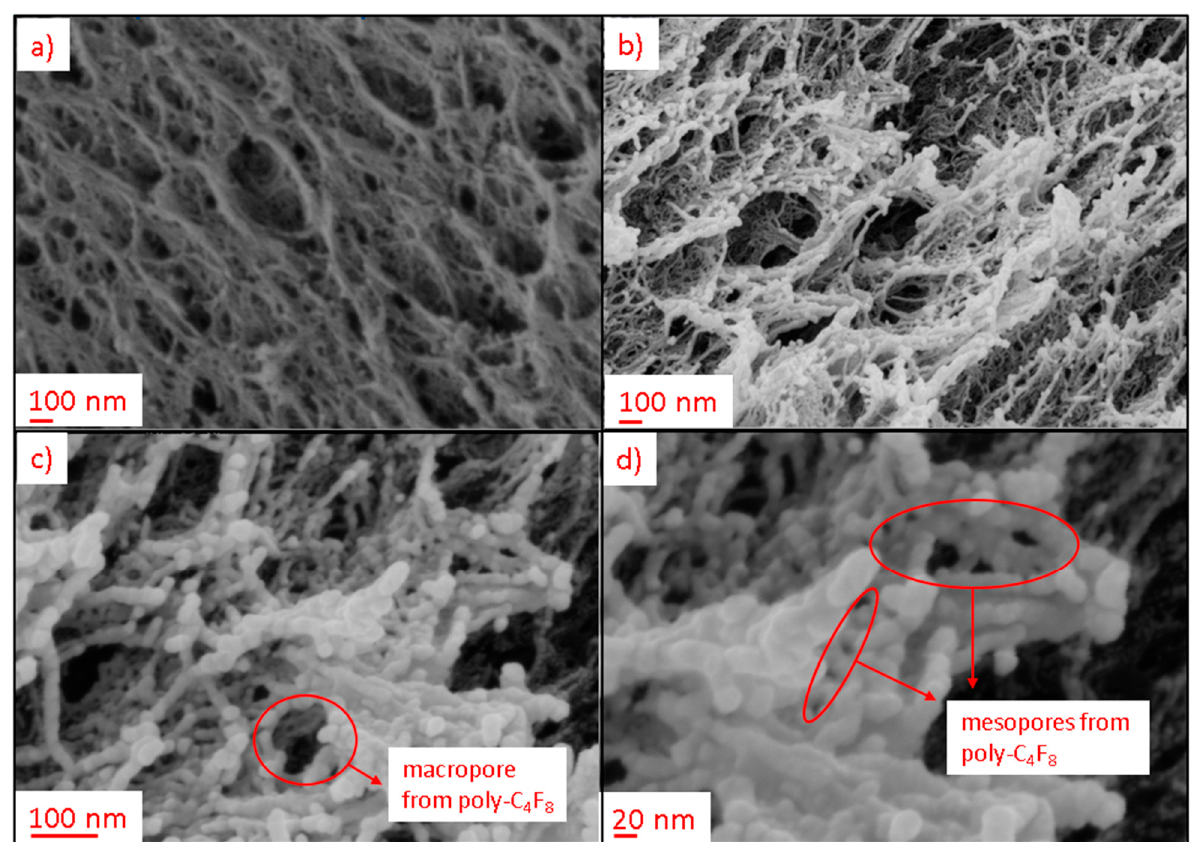
Figure 10. SEM pictures: ( a ) porous structure of non-treated alginate aerogel; ( b ) porous structure of treated alginate aerogel, coating material C 4 F 8 , CW, p input = 90 W, t = 50 min, distance from outer layer = 134 µm; ( c ) and ( d ) high-resolution pictures of poly-C 4 F 8 in alginate aerogel and new pores generated thereof.